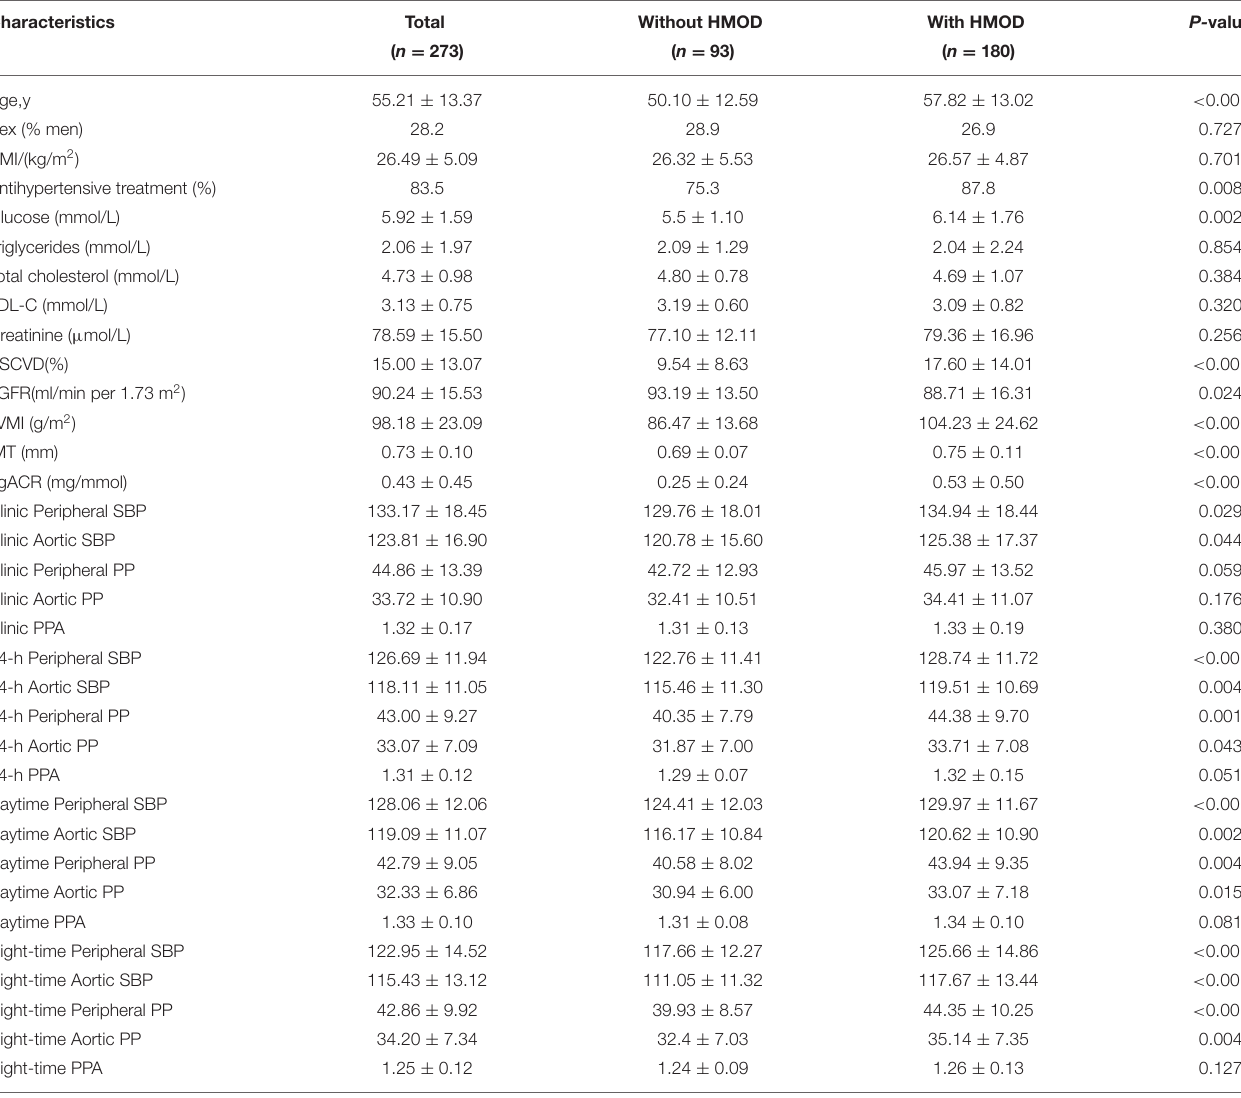
TABLE 1 | Characteristics of the study subjects.